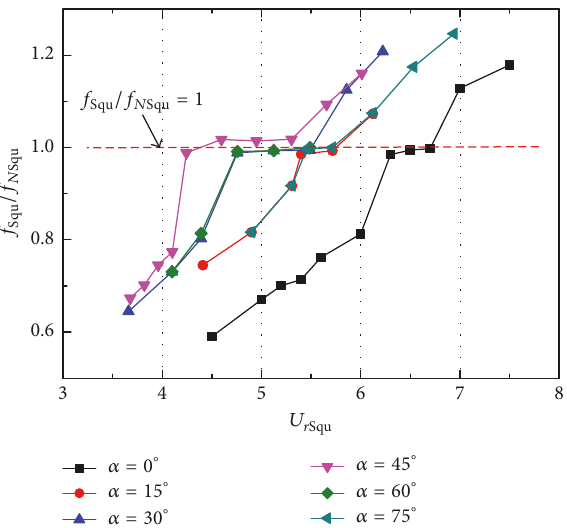
Figure 11: Nondimensional frequency of square column VIVPEH under different attack